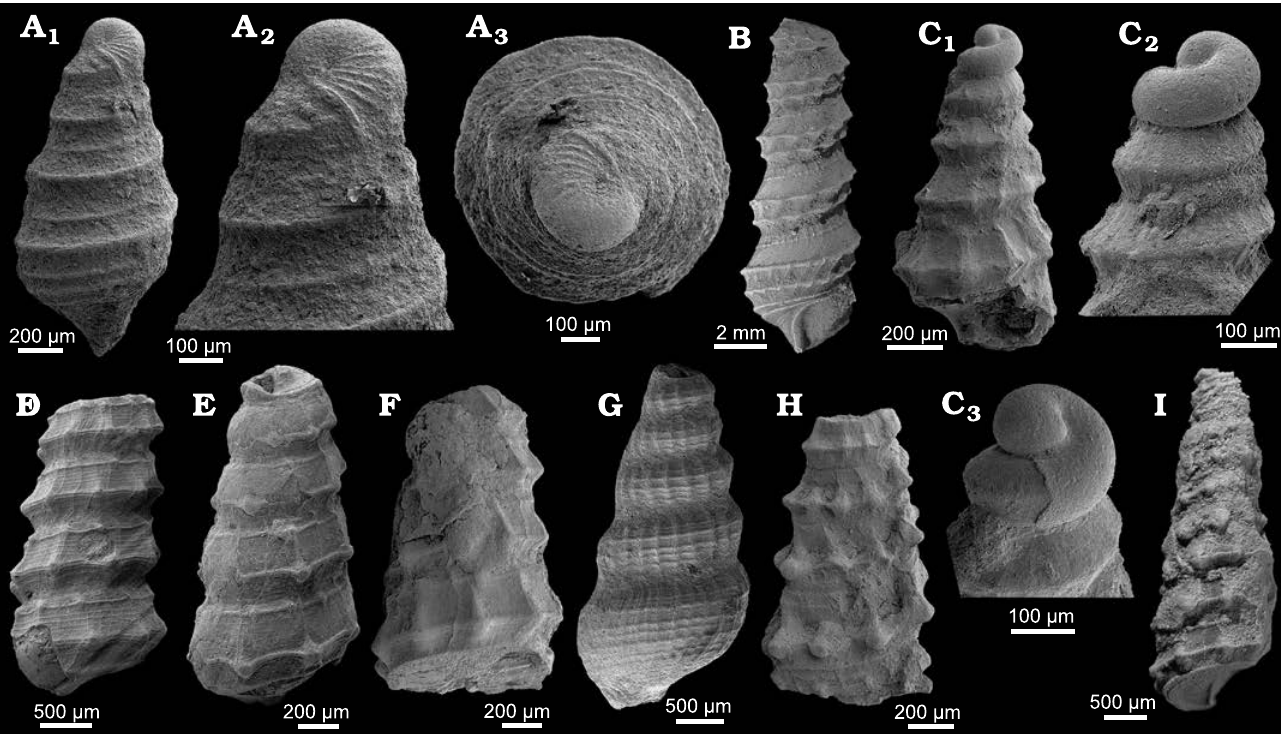
Fig. 21. Heterobranch gastropods from Misurina Landslide, northern Italy, Cassian Formation, Carnian, Upper Triassic. A . Promathildia cf. decorata (Klipstein, 1843), PZO 12729, in lateral (A 1 ) and apical (A 3 ) views; A 2 , close up to show heterostrophic protoconch, in lateral view. B . Promathildia subnodos a (Münster, 1841), PZO 12730, in apertural view. C . Promathildia cf. milierensis Zardini, 1980; PZO 12722, in apertural view (C 1 ); C 2 , close up to show heterostrophic protoconch, in lateral view; C 3 , close up to show heterostrophic protoconch, transition to teleoconch well visible, in